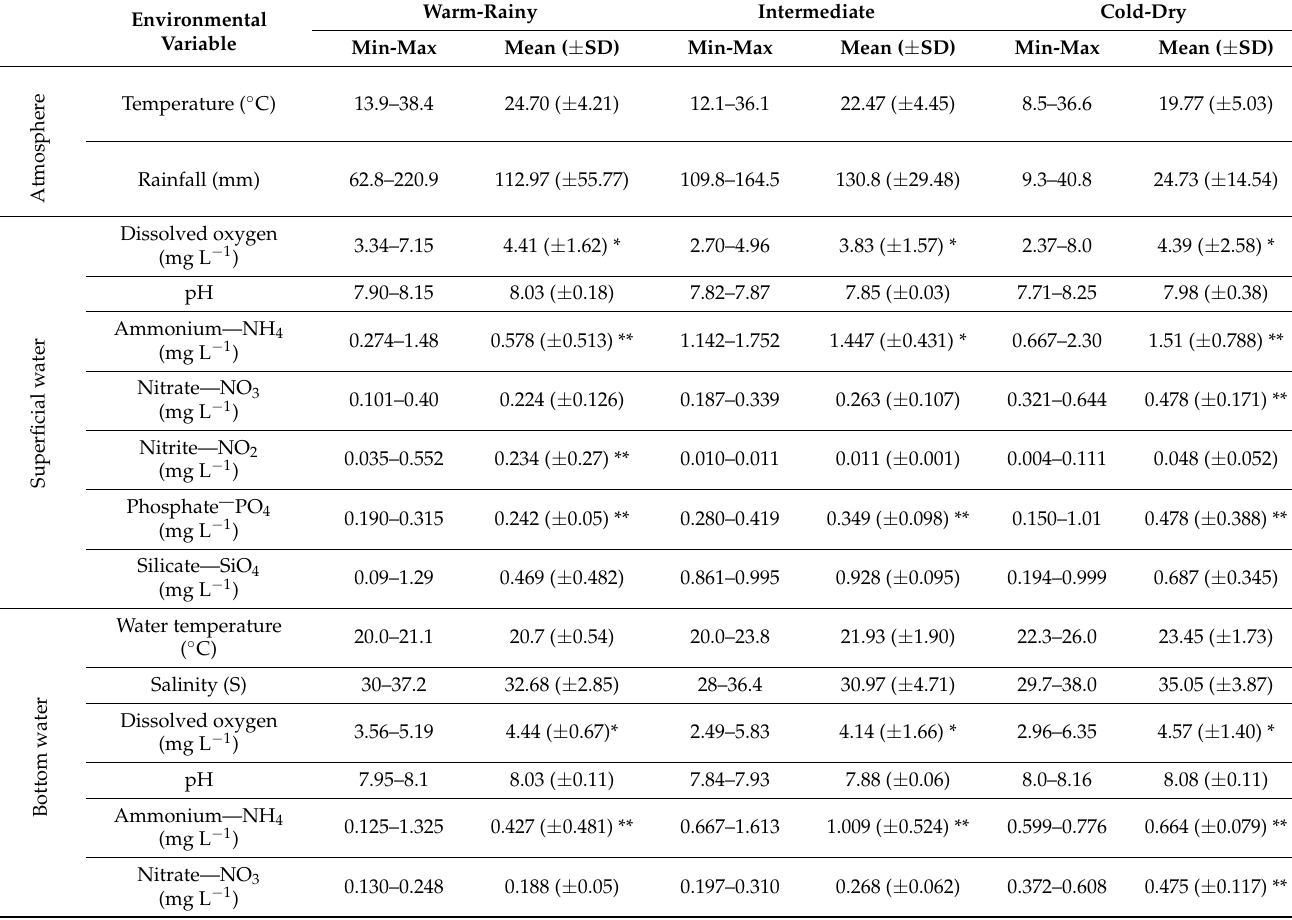
Table 2. Minimum, maximum (i.e., Min-Max) and mean ( ± standard deviation) values of environmen- tal variables in the different compartments (atmosphere, superficial and bottom water, and sediment) in the estuarine region of Guanabara Bay (Rio de Janeiro, Brazil). Environmental data are shown by group evidenced in the Principal Component Analysis (PCA). Local depth varied between 3.5 and 6 m according to the tide. * Below the minimum and ** above the maximum limit value established by the Brazilian legislation [51] for brackish water bodies class 1 (i.e., with uses appropriated for the protection of aquatic communities; primary contact recreation such as swimming, water skiing, and diving; irrigation of vegetables, fruit, and garden plants; aquaculture and commercial